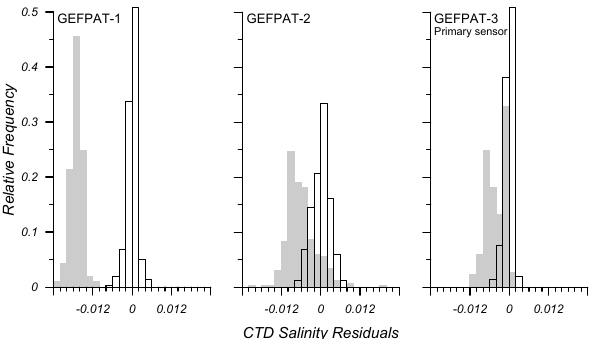
Figure 2. Relative frequency distribution of salinity residuals be- fore (shaded grey) and after (black solid line) CTD calibration for GEF Patagonia cruises.